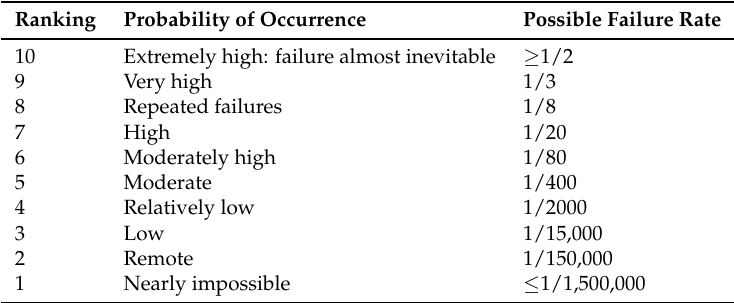
Table 1. Assessment rankings for occurrence in FMEA